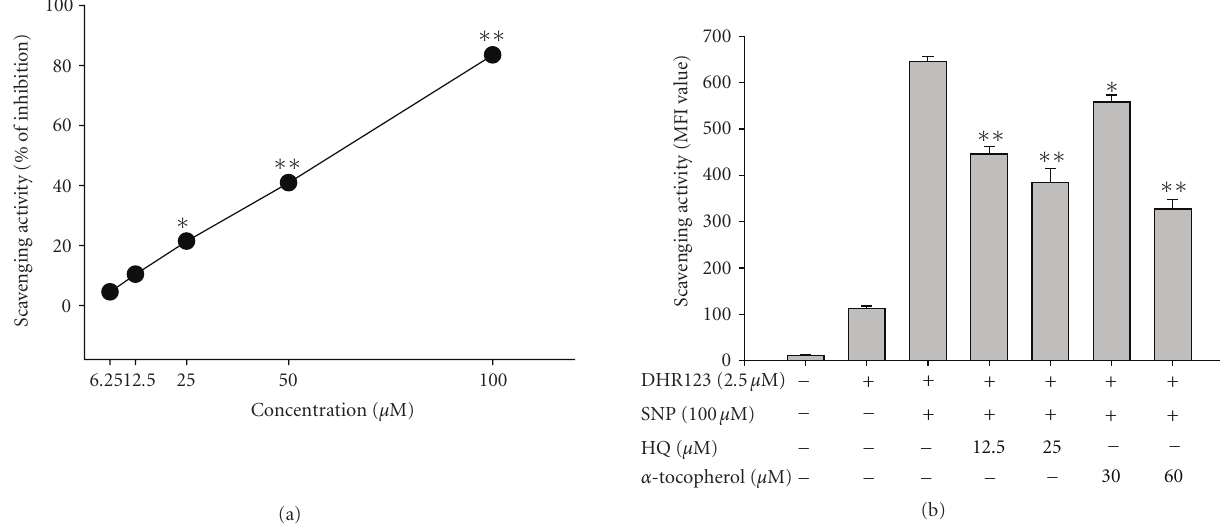
Figure 4: E ff ects of hydroquinone on ROS generation in SNP-induced RAW 264.7 cells. (a) Antioxidant e ff ect of hydroquinone was examined by DPPH assay as described in Section 2. (b) RAW264.7 cells (1 × 10 6 ) were pretreated with various concentrations of HQ (hydroquinone) in the presence or absence of SNP (100 μ M) for 30 minutes. The level of generated ROS was determined by flowcytometric analysis as described in Section 2 . ∗ p < . 05 and ∗∗ p < . 01 represent significant di ff erence as compared to control.